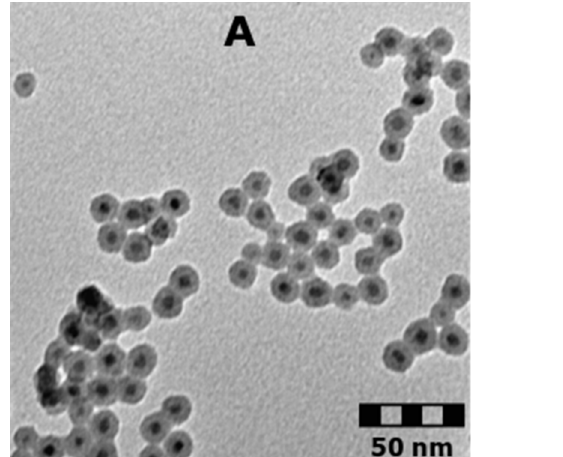
Figure 2. TEM micrographs of ( A ) as-made and ( B ) spent Fe@SiO 2 core–shell catalyst materials; experimental details for specimen B: prereduction under 100 % H 2 at 400 °C for 12 h, subsequent CO hydrogenation with H 2 :CO = 4.5 and p = 1 bar for 12 h at 350 and 390 °C.